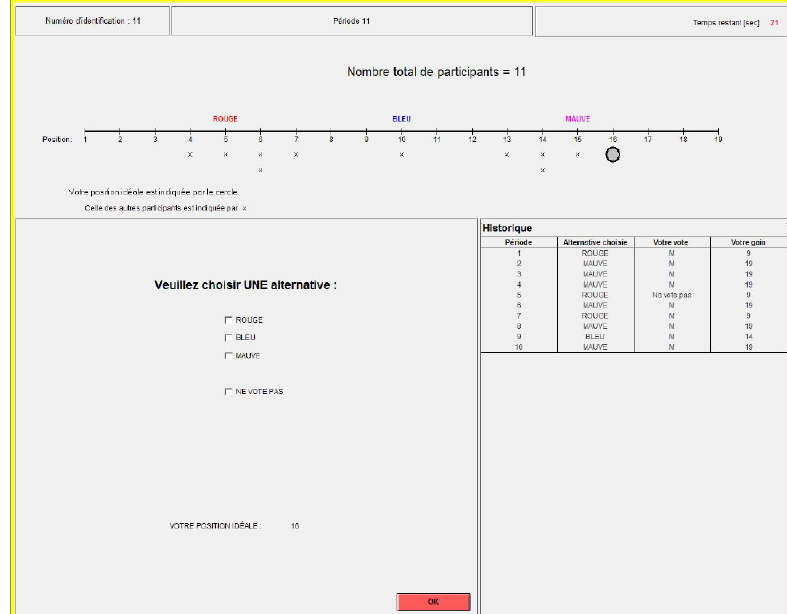
Figure A3. Vote Screen.